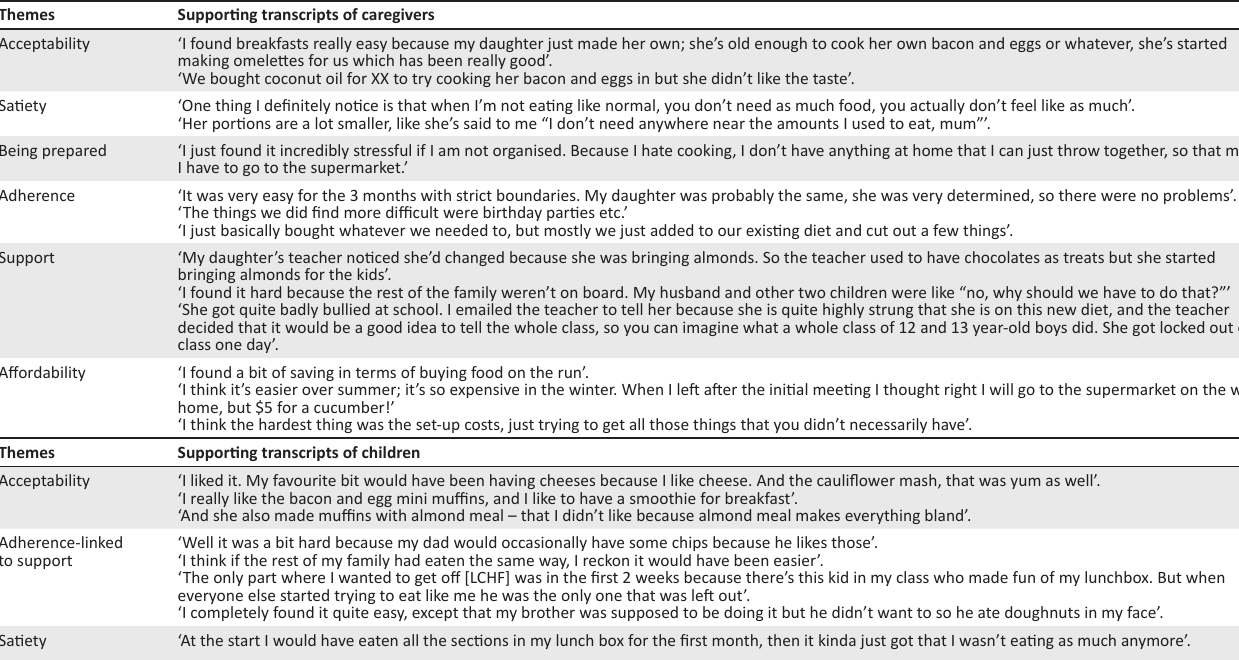
TABLE 2: Themes and supporting transcripts from caregivers and children. Themes Supporting transcripts of caregivers